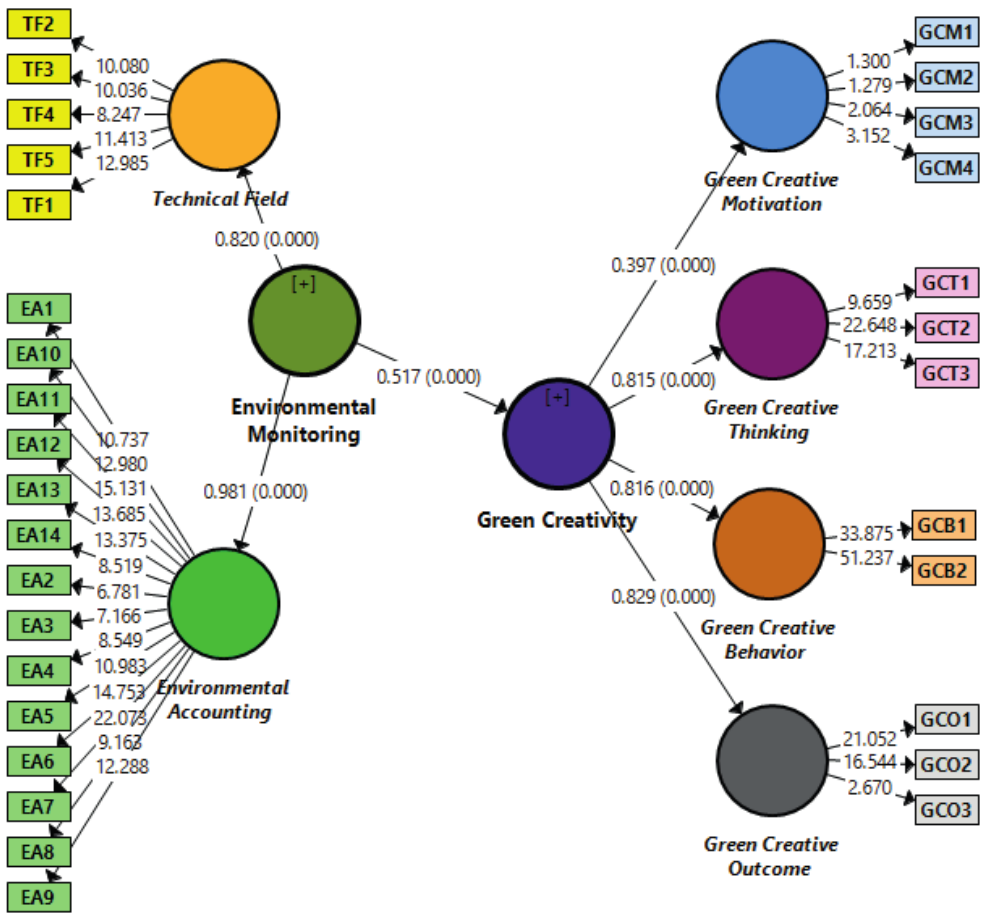
Fig. 3. The main structural